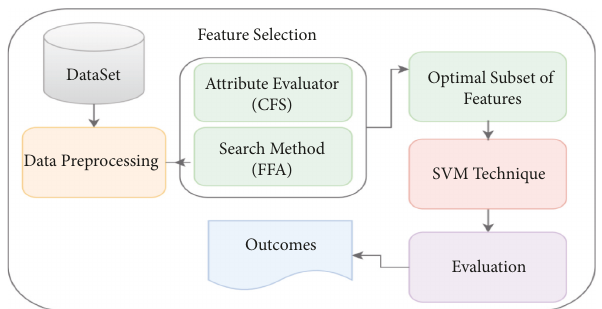
Figure 1: Detailed description of the proposed model for the fraud classification based on a machine learning technique and a bio- inspired